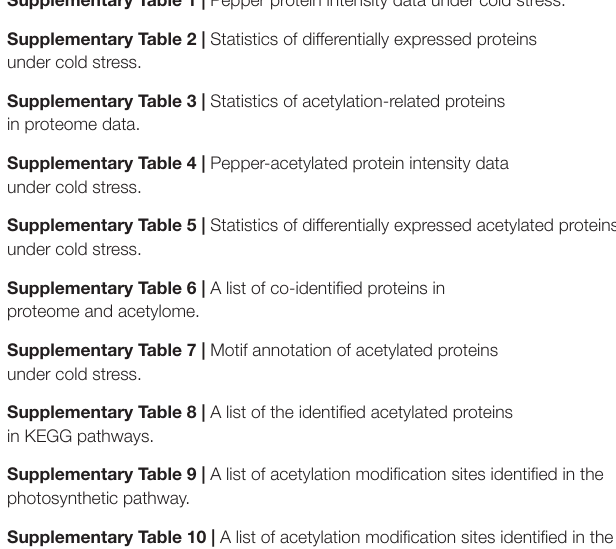
Supplementary Figure 2 | Western blotting with antibodies. (A) Anti-crotonyllysine. (B) Anti-2-hydroxyisobutyryllysine. (C) Anti-succinyllysine. (D) Anti-acetyllysine. Supplementary Figure 3 | Transmission electron microscope analysis of A188 (cold-resistant variety) and A122 (cold-sensitive variety) under cold stress and recovery stages. Supplementary Figure 4 | Venn diagrams of samples. (A) Numbers of proteins identified in each treatment. (B) Numbers of differentially expressed acetylation proteins under cold stress. Supplementary Figure 5 | Statistics on the number of acetylation sites in proteins. Supplementary Figure 6 | Statistics of co-identified proteins in proteome and acetylome. Supplementary Figure 7 | Subcellular localization analysis of acetylated proteins. Supplementary Table 1 | Pepper protein intensity data under cold stress. Supplementary Table 2 | Statistics of differentially expressed proteins under cold stress. Supplementary Table 3 | Statistics of acetylation-related proteins in proteome data. Supplementary Table 4 | Pepper-acetylated protein intensity data under cold stress. Supplementary Table 5 | Statistics of differentially expressed acetylated proteins under cold stress. Supplementary Table 6 | A list of co-identified proteins in proteome and acetylome. Supplementary Table 7 | Motif annotation of acetylated proteins under cold stress. Supplementary Table 8 | A list of the identified acetylated proteins in KEGG pathways. Supplementary Table 9 | A list of acetylation modification sites identified in the photosynthetic